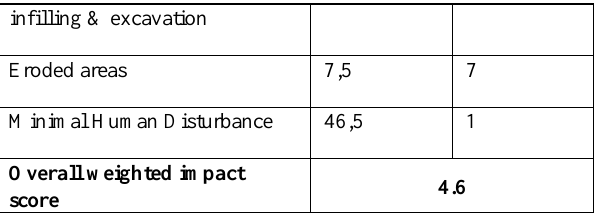
Table 8. WET-Health vegetation module completed with the UAV multispectral